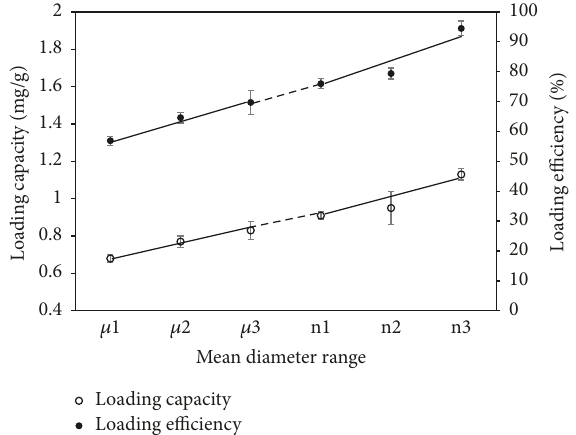
Figure 5: Effect of mean diameter range of cellulose beads on the loading capacity and efficiency of